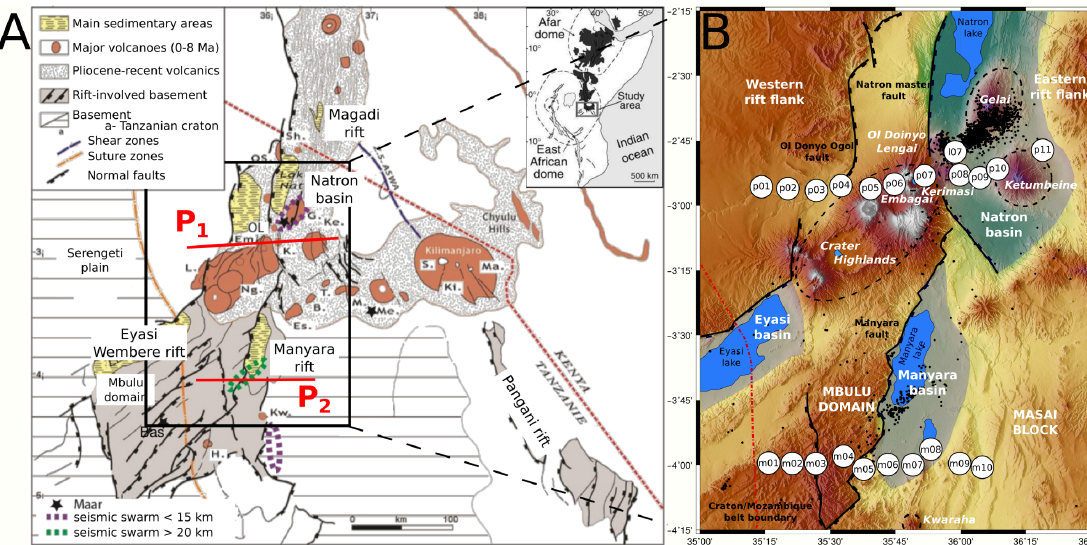
Figure 1. ( A ) Main structural and magmatic features of the North Tanzanian Divergence (modified from Le Gall et al. [4]). The red lines P1 and P2 indicate the two magnetotelluric (MT) profiles location. ( B ) Zoom showing the morphostructural framework (Shuttle Radar Topography Mission (SRTM) Digital Elevation Model) and the two MT profiles (numbered circles). Black dots are the earthquakes from Albaric [14] relocated in a 3-D velocity model [15]. Volcanoes: B. Burko, Em. Embagai,